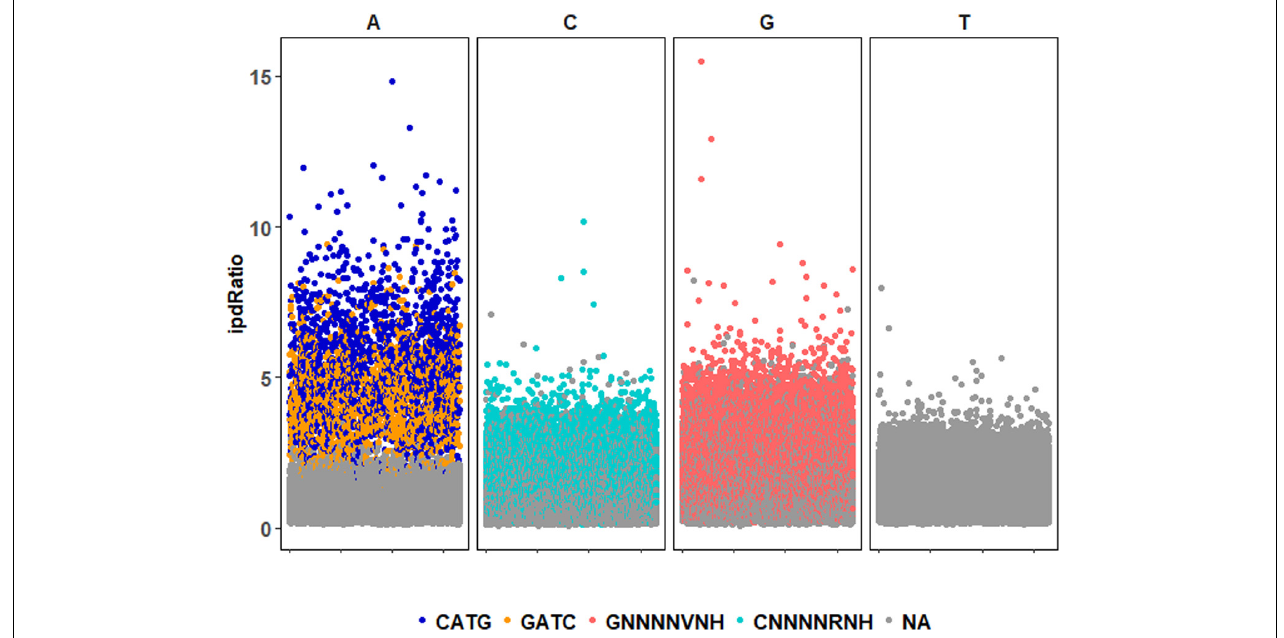
FIGURE 3 | ipdRatio score for nucleotides in one replicate of the PBCV-1 genome at 30-fold read recruitment coverage. Dot color denotes association with a motif detected by motifMaker.sh. There are nearly imperceptible differences between the three replicates, which is why only one is shown here. The x-axis indicates genome position of each motif